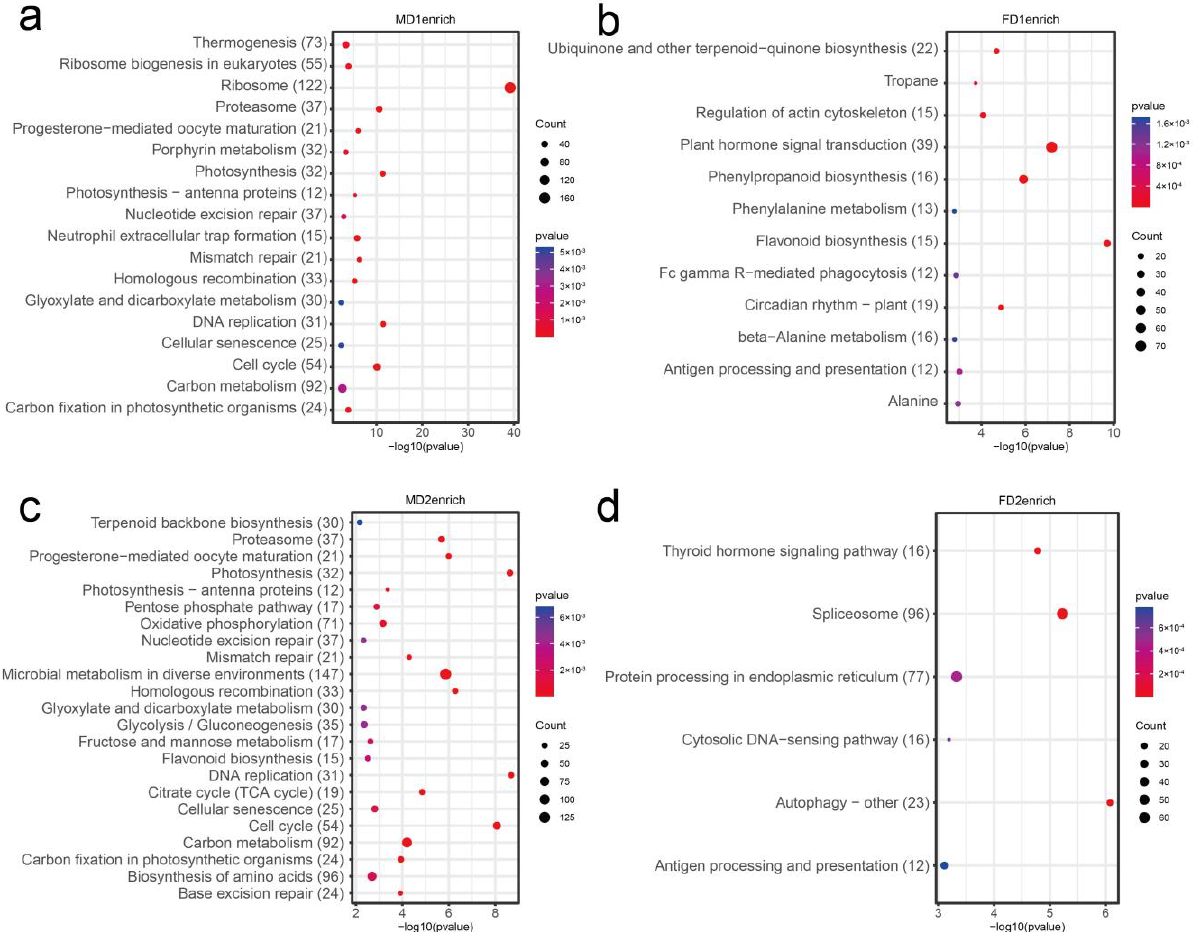
Figure 7. KEGG pathway analysis of flower bud initial differentiation and floral primordium for- mation. The enriched pathways of male ( a , c ) and female ( b , d ) flower buds in the initial differentia- tion stage (MD1, FD1) and formation of flower primordial stage (MD2, FD2), respectively. The ver- tical and horizontal axes indicate the enriched pathways and the enrichment factor uniqueness.